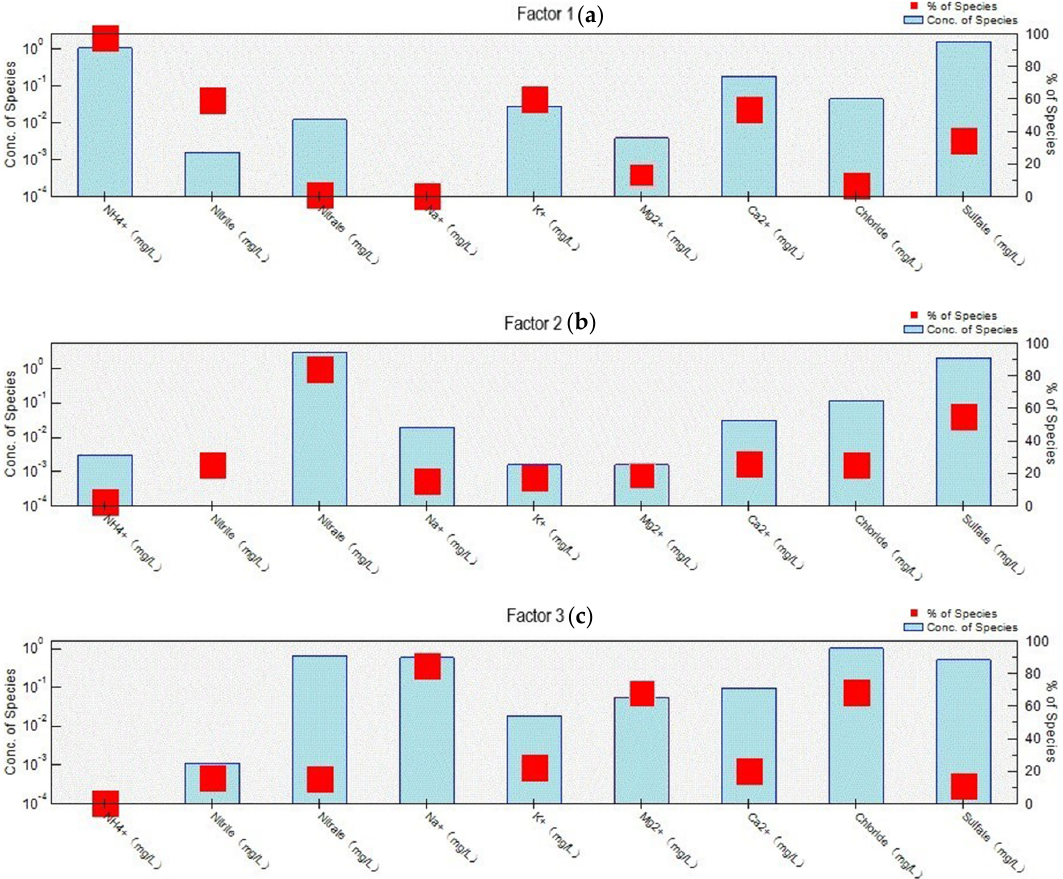
Figure 4. The contribution of different factors: ( a ) Factor 1 represents fertilization and also biomass combustion. Biomass burning; ( b ) Factor 2 represents secondary aerosols; ( c ) Factor 3 represents sea salt aerosol of marine source.